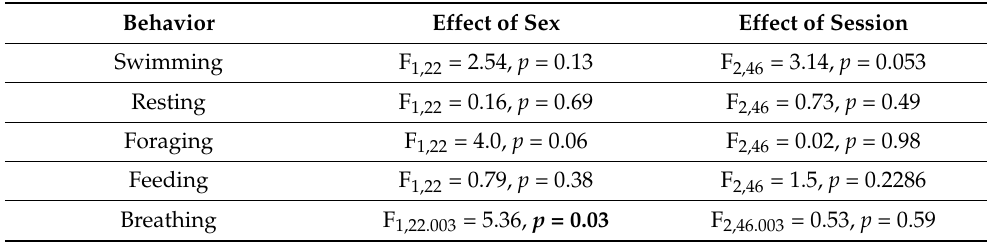
Table 2. Results of linear mixed models with sex and time of observation as explanatory variables. Significant p values are in bold.